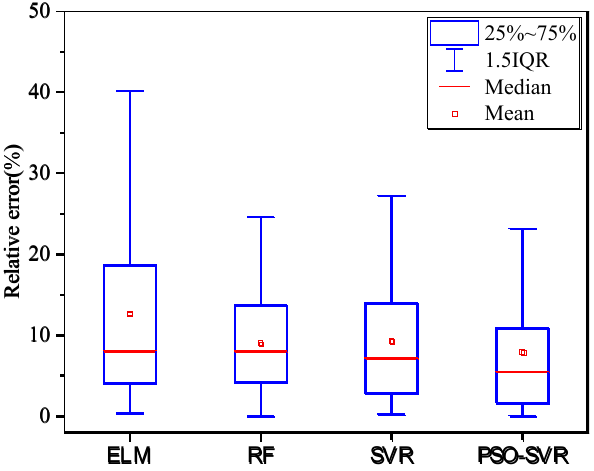
Figure 6. Relative error of model prediction results for the test set. Table 3. Evaluation indicators of four models.